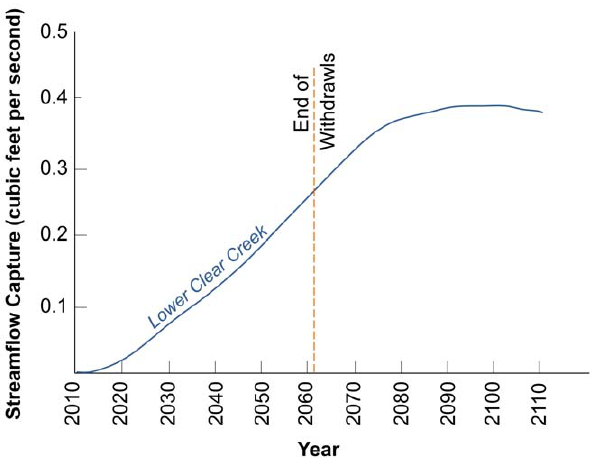
Figure 4. Cumulative effects of groundwater pumping on streamflow depletion even after pumping is stopped. In this case, from Lower Clear Creek in Arizona, streamflow continues to decline for nearly 30 years after pumping is stopped in 2060. Adapted from Alley and Leake (2007).